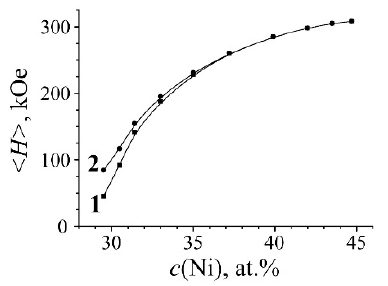
Figure 1. The Mössbauer spectra, p ( H ) distributions and the reconstituted spectral components γ 1 , γ 2 , and α of the FeNi 31.1 alloy. Treatment: ( a ) tempering at 1050 °C, with subsequent quenching (i) in water and additional quenching (ii) using liquid nitrogen for the formation of α -martensite; ( b – e ) the treatment mentioned in ( a ) with the following α → γ transformation in the course of slow heating (0.2 K/min) up to 400, 470, 490, and 520 °C, respectively.